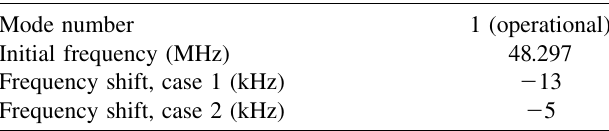
force is (cid:5) 12 : 5 Hz = N . As can be seen from Tables IVand V,